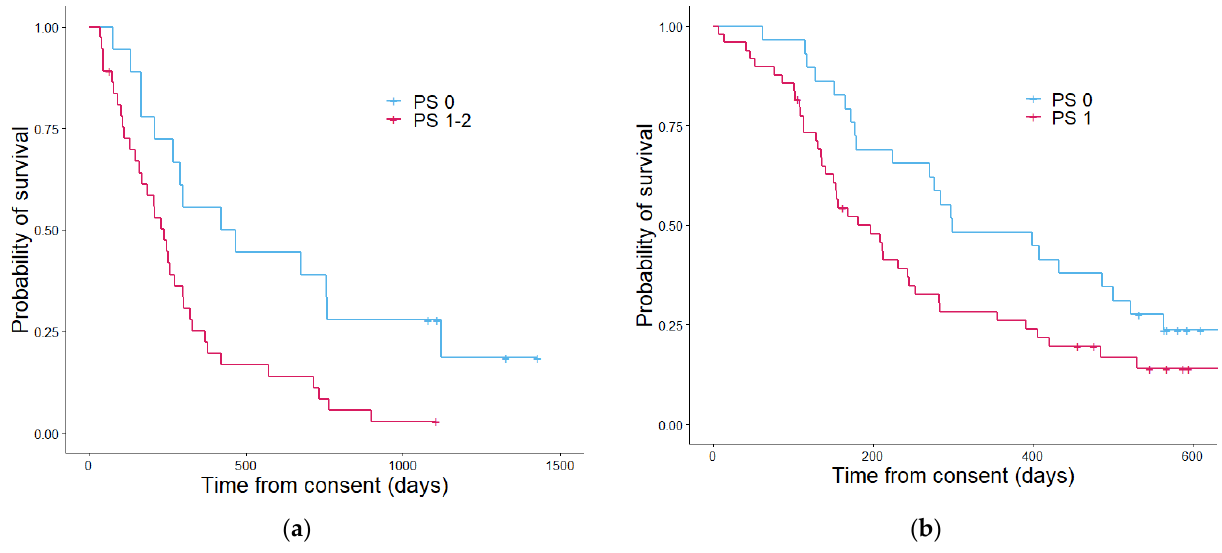
Figure 5. Kaplan–Meier curves showing the overall survival determined by the performance status in the discovery cohort ( a ) and the validation cohort ( b ). In the discovery cohort ( a ) patients with a PS score of 0 had a median estimated overall survival in days of 628 and patients with a PS score of 1–2 had a median overall survival of 296 days. Table 3. In the validation cohort ( b ) the median overall survival estimates in days patients with a PS of 0 was 298 and for PS score 1–2 was 196. The p value was 0.084.